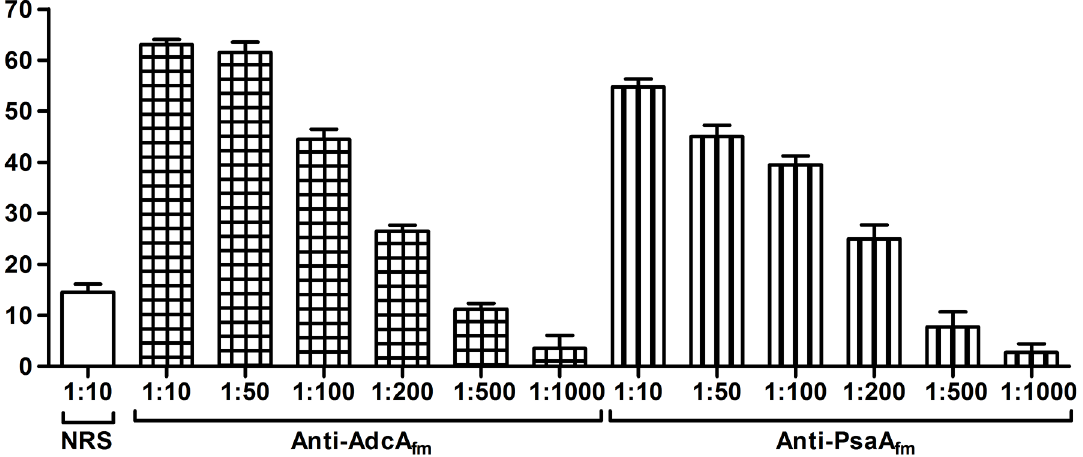
Fig 2. Opsonophagocytic assay used to test the ability to mediate opsonic killing in the strain E . faecium E155 by antibodies raised against the recombinant proteins at different dilutions. α AdcA fm (square grid) and α PsaA fm (vertical stripes), compare with the activity of pre-immune rabbit serum (white bar). The different sera and the corresponding dilutions used in the OPA are indicated in the abscissa and the % killing in the ordinate. Bars represent the mean of data and the error bars represent the standard error of the